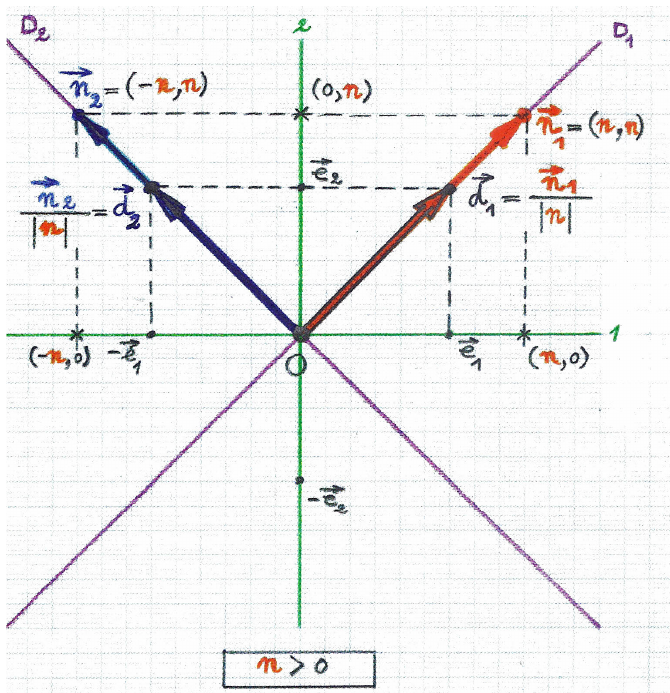
Figure 5. Two normalised null vectors.